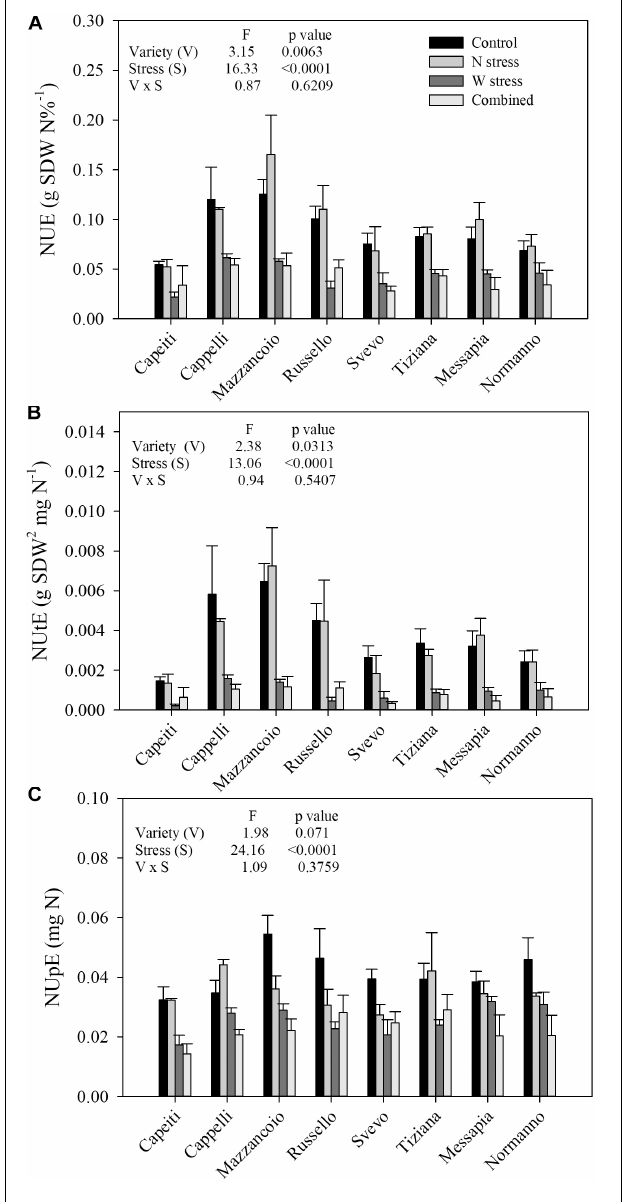
FIGURE 1 | Single and combined effect of N and water stress on nitrogen use efficiency (A) , nitrogen utilization efficiency (B) , and nitrogen uptake efficiency (C) of eight durum wheat varieties grown in a controlled environment. Values are means ( n = 5) ± SE.